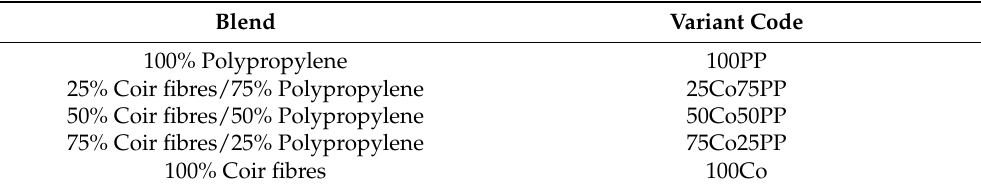
Table 1. Experimental